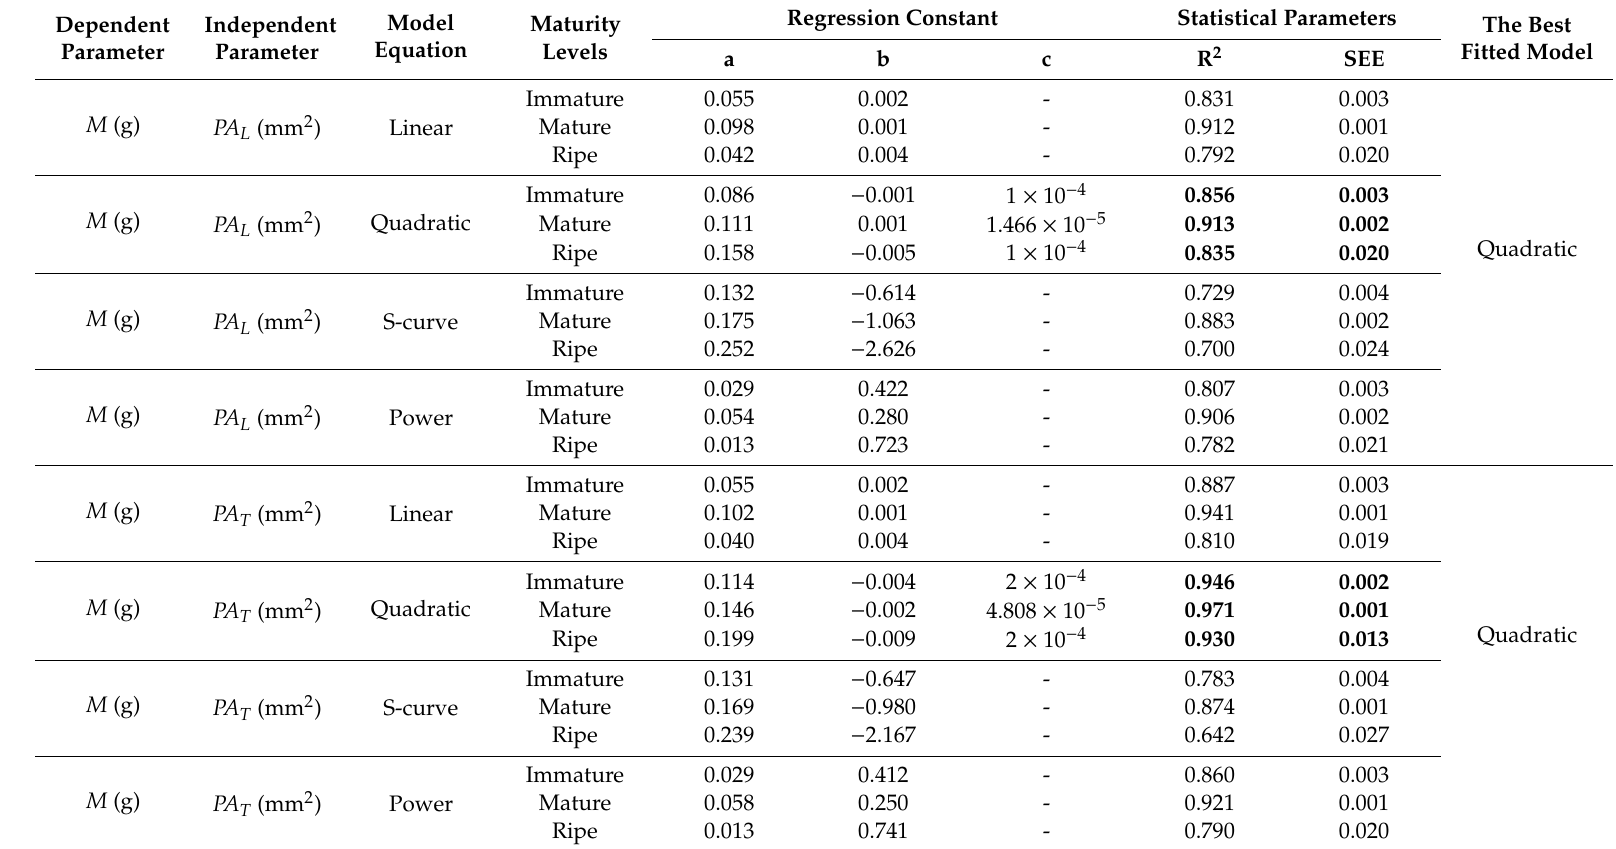
Table 4. Mass models of pepper berries based on projected